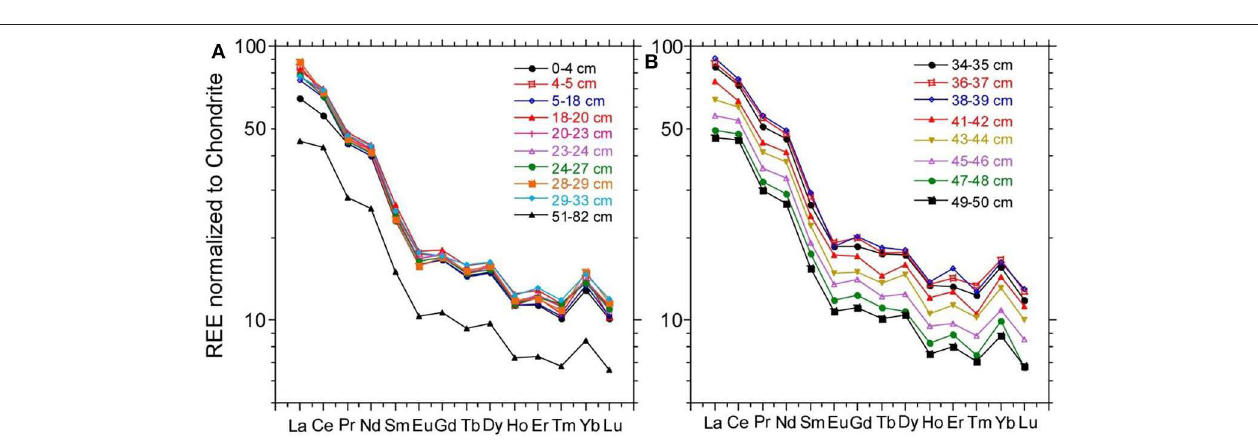
FIGURE 10 | (A,B) Rare earth element patterns normalized to North American shale composition at different depths in the Manzherok Lake sediment core.